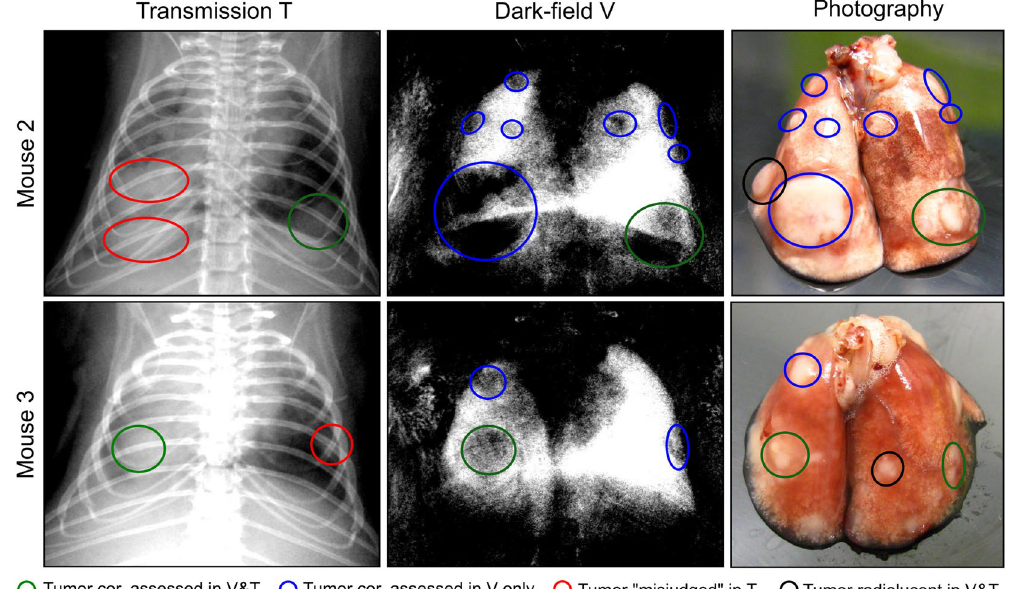
Figure 4. Improved assessment of tumor size, shape and delineation using X-ray dark-field radiography. Transmission and dark-field radiograms of two mice with lung cancer are taken from Fig. 2 and evaluated by a blinded reader. The green ellipses indicate tumors, which were correctly assessed in both imaging channels. The red ellipses indicate tumors which were detected in the transmission image, but misjudged with respect to size or shape, e.g. being mistakenly classified as separated (Mouse 2) or round (Mouse 3). Blue ellipses account for tumors which were correctly assessed within the dark-field radiogram only. Overlooked/missed tumors are indicated on the photograph by black ellipses.